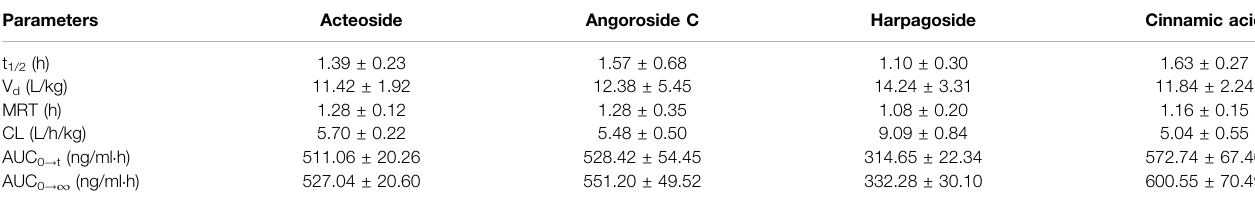
TABLE 3 | The main pharmacokinetic parameters of the four analytes after sublingual intravenous administration to six rats. Parameters Acteoside Angoroside C Harpagoside t 1/2